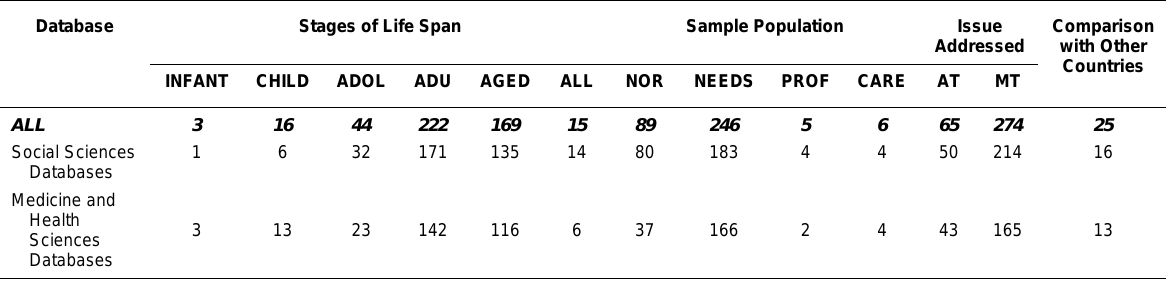
Classification of Studies about the QOL in Hong Kong in Four Dimensions (Stages of Life Span, Sample Population, Issue Addressed, and Comparison with Other Countries) According to Two Broad Categories of Databases (Social Sciences Databases and Medicine and Health